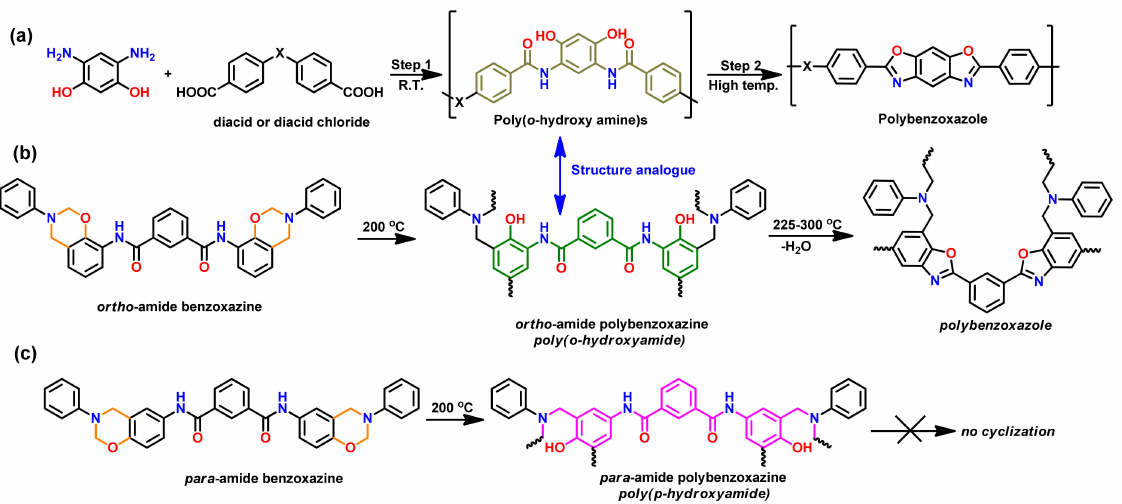
Figure 26. ( a ). Two-step condensation synthesis of polybenzoxazole via intermediate poly( o -hydroxyamine); ( b , c ) probable synthetic route of polybenzoxazole from o -amide benzoxazine monomer, p -amide benzoxazine monomer disfavor cyclization reaction